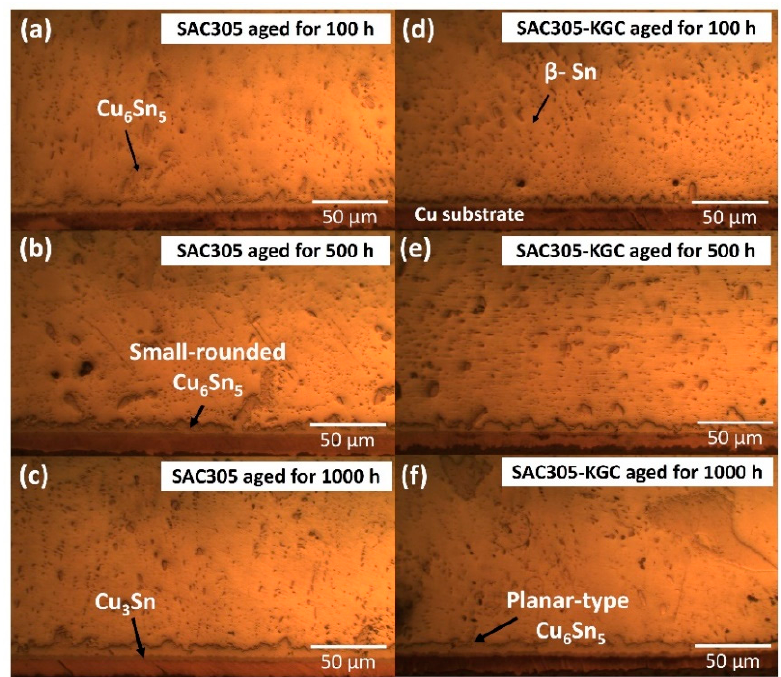
Figure 9. Interfacial IMC layer subjected to isothermal ageing at 150 °C. Non-reinforced SAC305 at